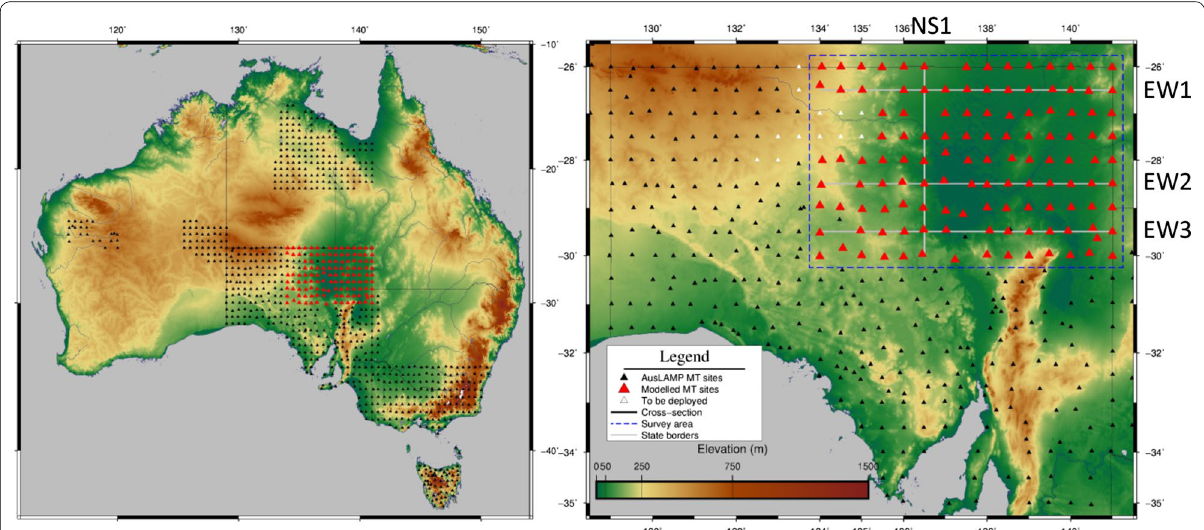
Fig. 1 Left: AusLAMP long-period MT site deployed locations (black) across Australia. Sites used in this study are red. Right: AusLAMP long-period MT site deployed locations (black) and intended locations (white) over topography in South Australia. The red sites were used in the 3D modelling presented in this study. The survey area is outlined in blue. The grey lines show the locations of the cross sections used for visualising modelling results in later